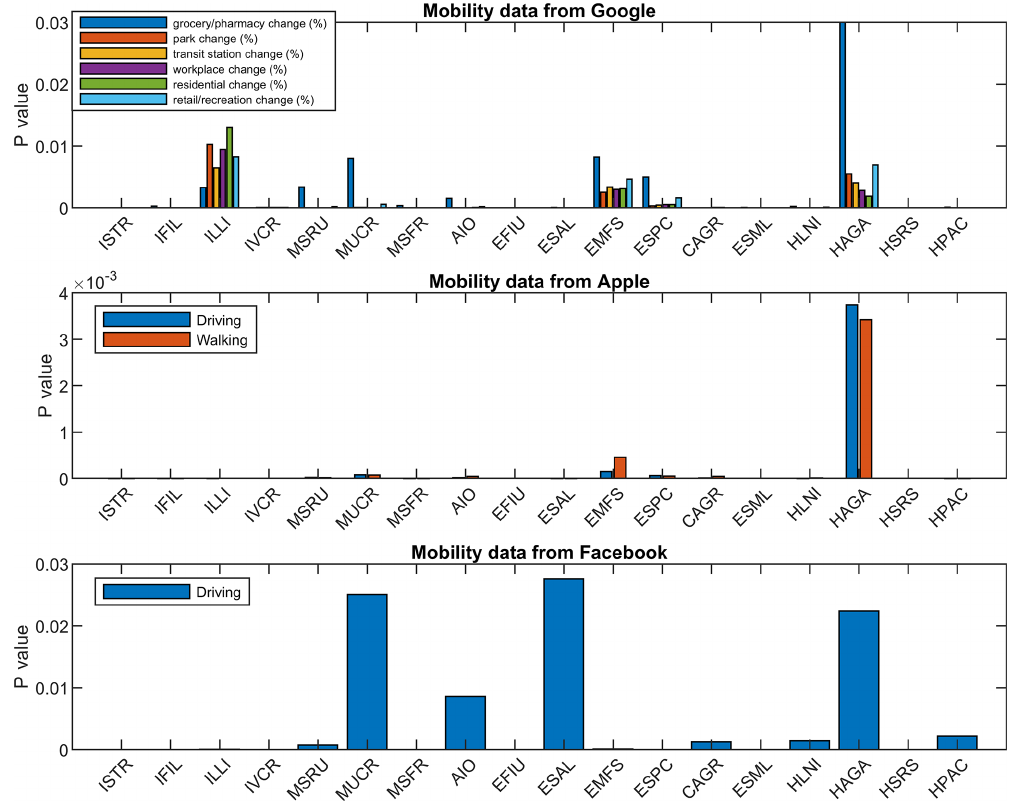
Figure A3. Probability values ( p values), obtained by the Spearman correlation analysis performed between seismic rms amplitude at the different stations and the human mobility parameters, as provided by Google, Apple and